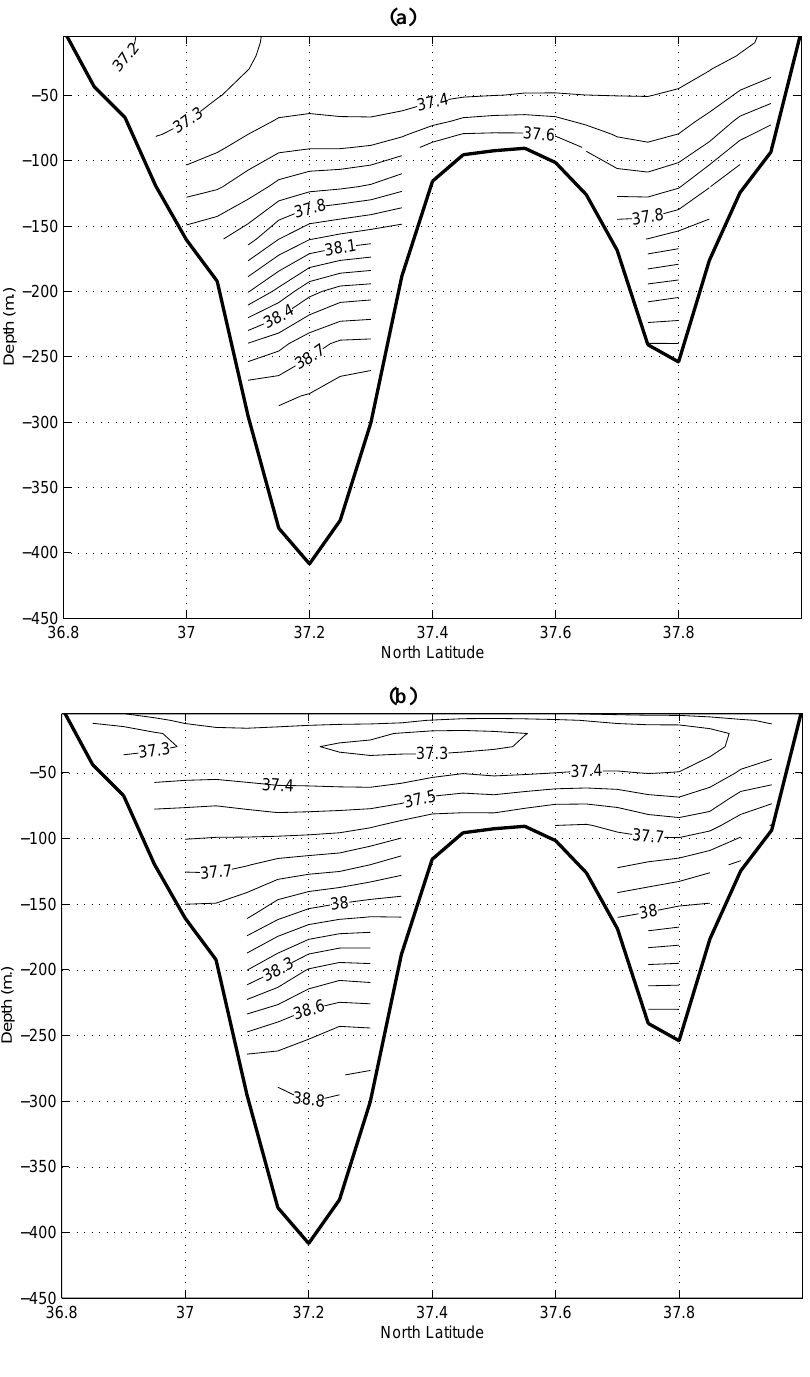
Fig. 16. The simulated 10-day averaged vertical section of salinity across the section from 11.1 ◦ E and 36.85 ◦ N (Tunisia) to 12.3 ◦ E and 38.0 ◦ N (Sicily) in (a) February and (b) August. The contour interval is